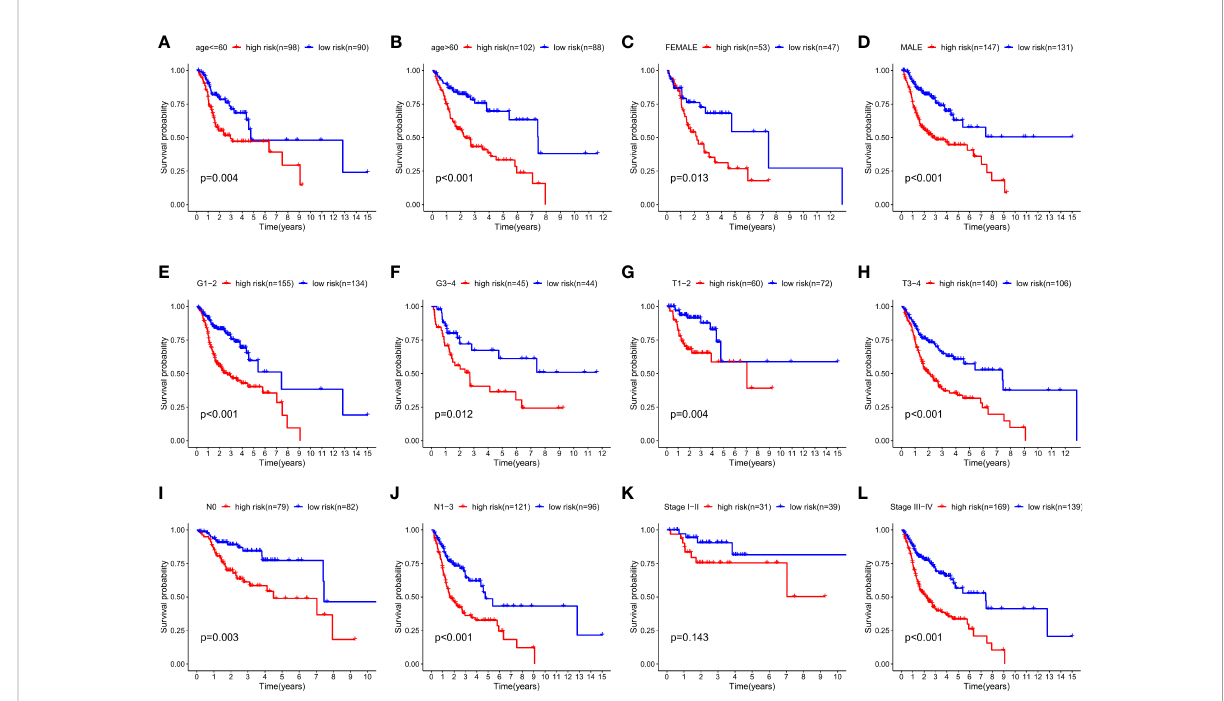
FIGURE 6 Kaplan-Meier survival curves for the high- and low-risk groups strati fi ed by clinical factors. (A) Age ≤ 60 years, (B) Age > 60years, (C) gender (female), (D) gender (male), (E) T1-2, (F) T3-4, (G) N0, (H) N1-3, (I) stage I-II, (J) stage III-IV, (K) grade 1-2, and (L) grade